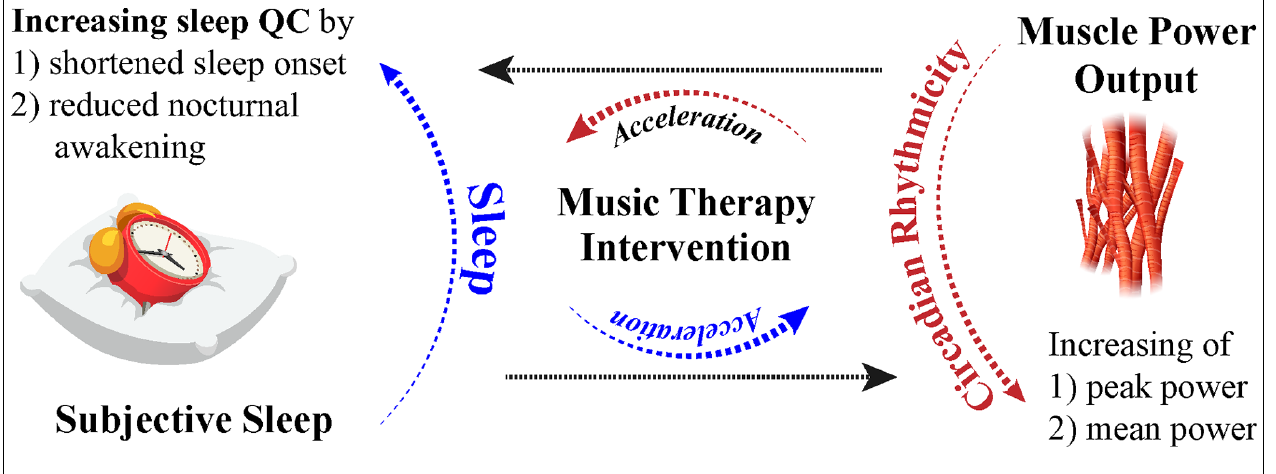
FIGURE 2 | Illustration for the effects of MT intervention in the context of Sleep and CR.